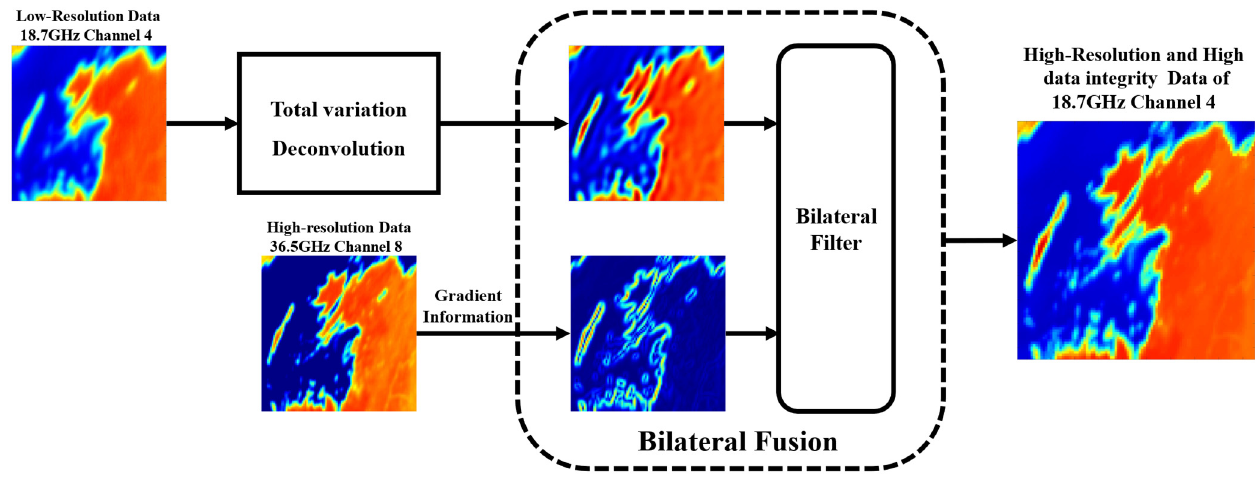
Figure 1. Illustration of the proposed spatial resolution and data integrity TVBF+ method.